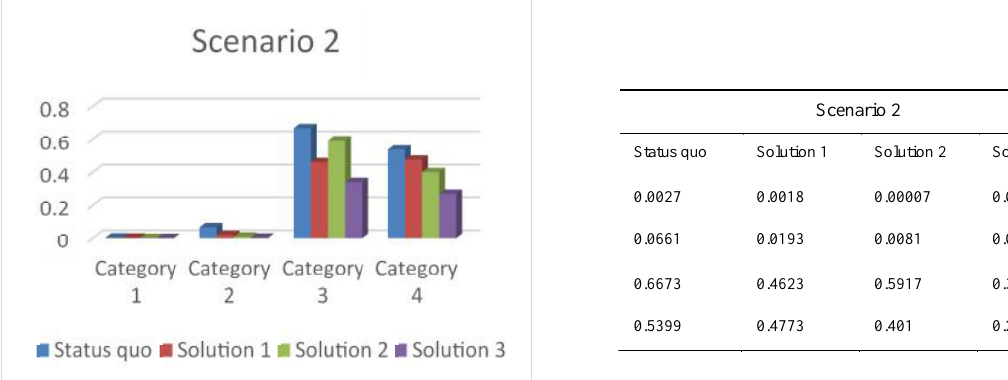
Fig. 8: The results of Vehicle-pedestrian accident probabilities after the adoption of the proposed solutions from Bahonar Square to Saeedi Street